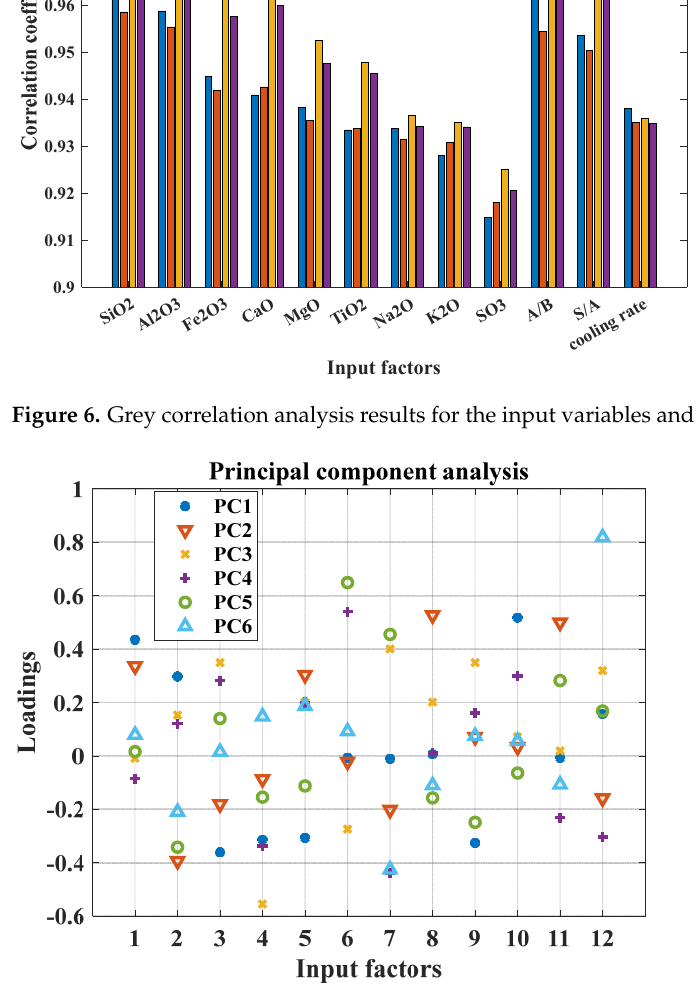
Figure 6. Grey correlation analysis results for the input variables and model parameters.